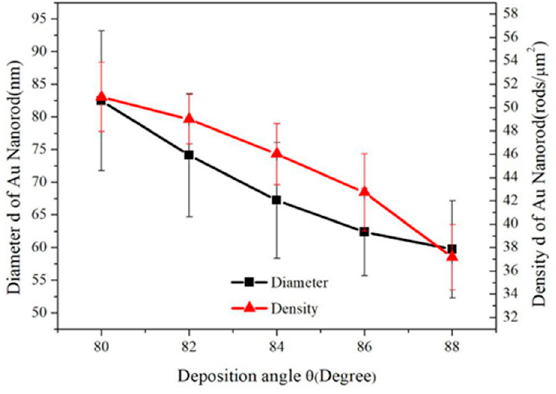
Figure 8. The plot of Au nanorod diameter and density vs. the deposition angle θ .